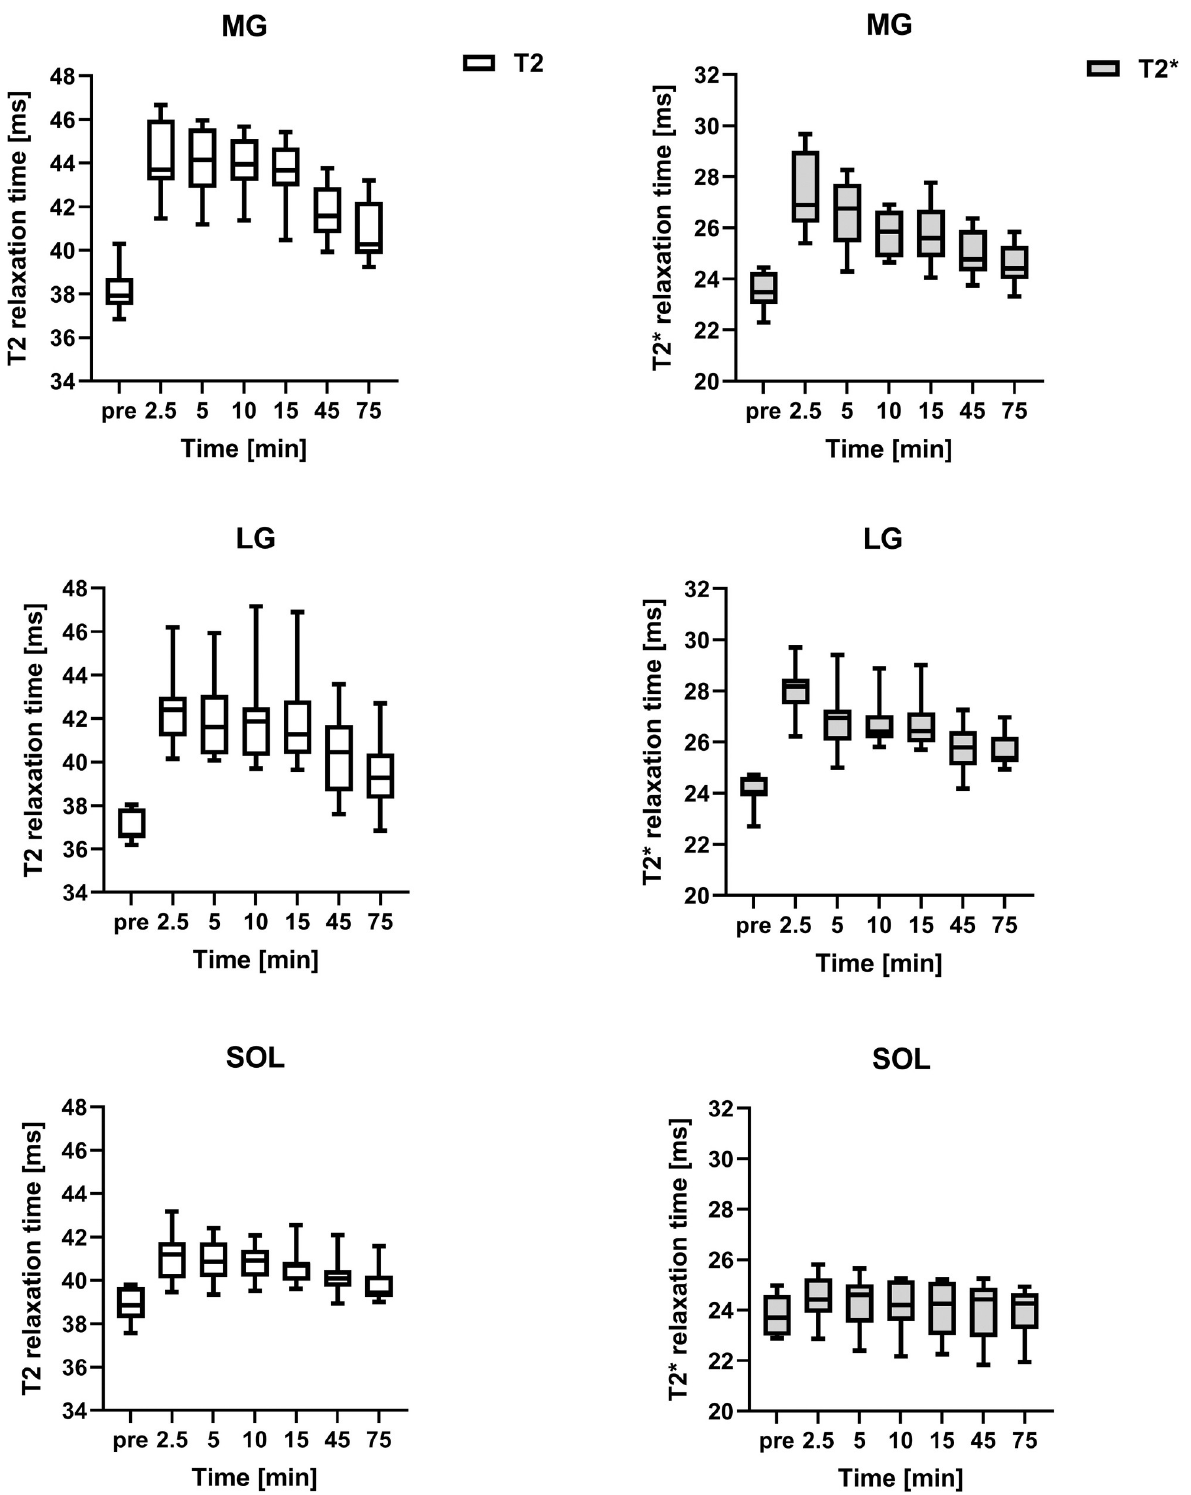
Fig 2. Mean T2 � and T2 relaxation time of the 10 participants. Abbreviations: MG = medial gastrocnemius muscle, LG = lateral gastrocnemius muscle, SOL = soleus muscle. Note: the time intervals between the time points indicated in the x-axis are variable.